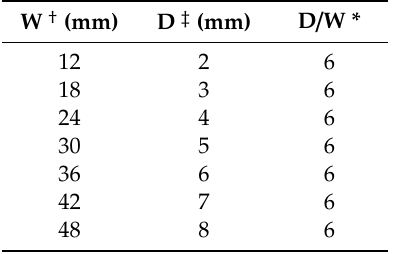
Figure 1. ( a ) Specimen dimensions (in mm): width (W) and diameter (D) are variable, as indicated in Tables 1–4. ( b ) Schematic layout of the experimental setup. The numbered positions (1–3) in blue in both figures indicate the hammer impact positions. Table 1. Group 1: Constant width / diameter ratio with center hole.